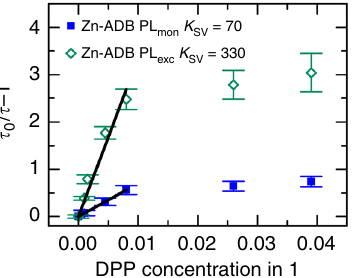
Fig. 4 Stern – Volmer analyses. Stern – Volmer plot for the DPP containing Zn-ADB (1) SURMOF-2 structures, plotted by comparing the lifetime values of the individual excited states in presence of the DPP in various concentrations. The error bars are determined by propagating the uncertainties in the fi ts shown in Supplementary Fig. 16